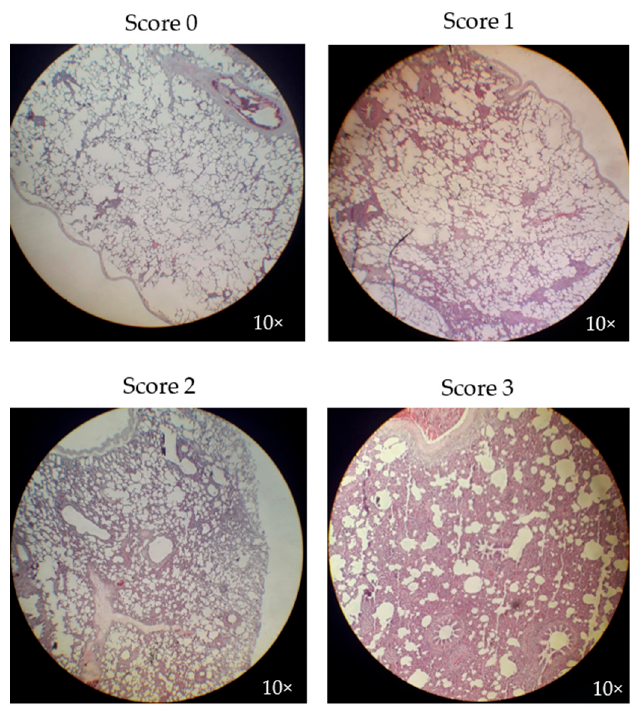
Figure 6. Microscopic lung lesion evaluation of immunized pigs at the end of the experiment. The scoring system utilized to evaluate the severity of the lung lesions found in pigs was as follows: 0—no significant lesions; 1—mild significant lesions; 2—moderate significant lesions; and 3—severe significant lesions. Tissue samples were magnified at 10 × . Table 1. Microscopic lung lesion scores for the groups. Number of Pigs with Each Microscopic Lung Lesions Score